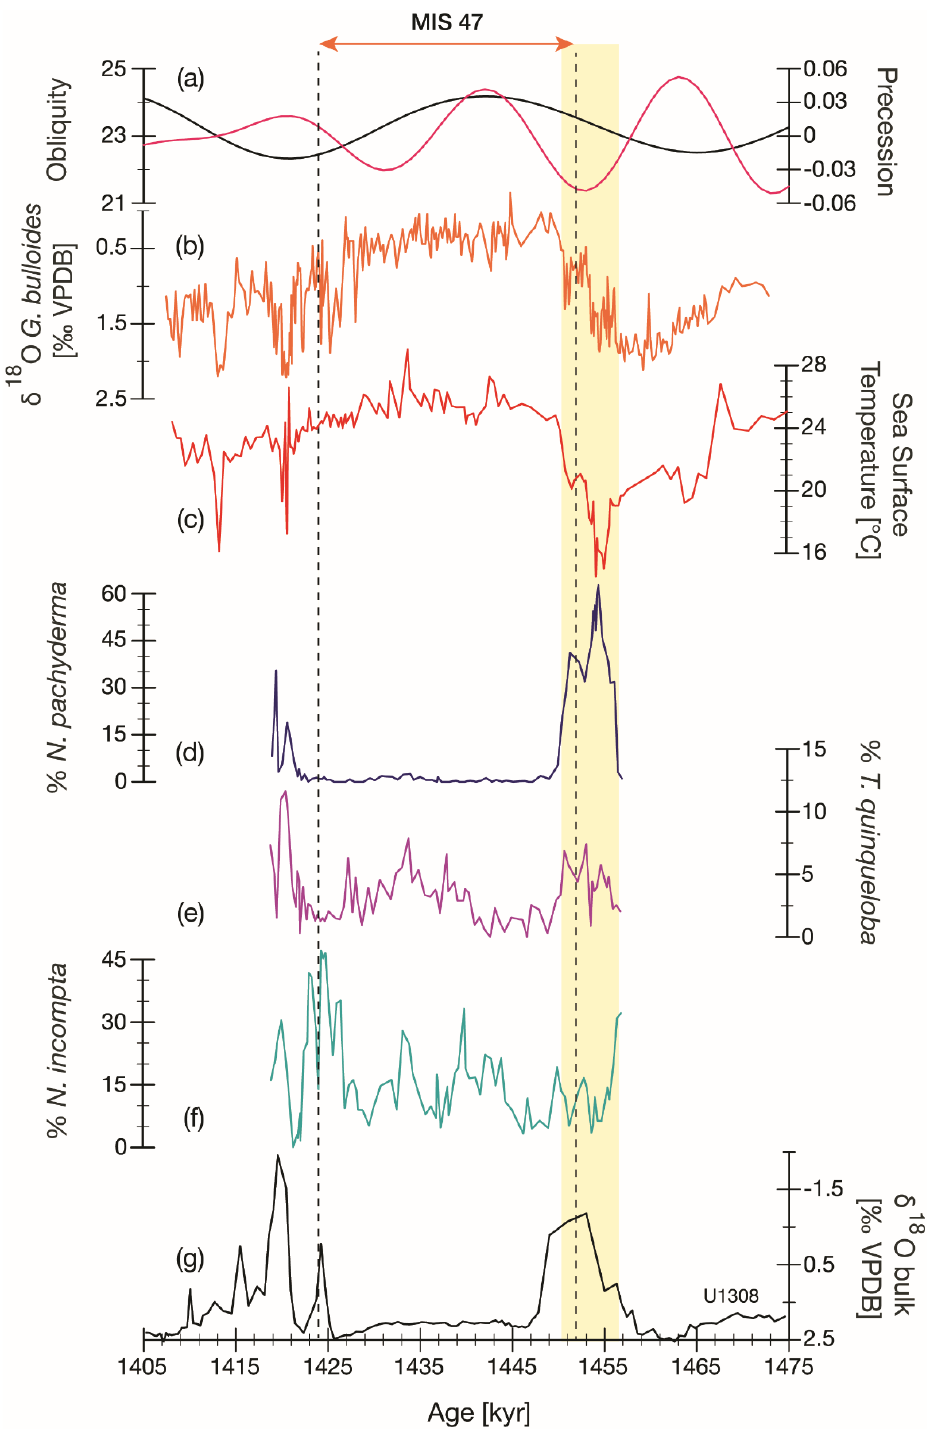
Figure 5. Terminal stadial event of MIS 48 (yellow bar) and millennial-scale variability in MIS 46 at IODP Site U1387: ( a ) Obliquity ( black ) and Precession (dark magenta) [63]; ( b ) G. bulloides δ 18 O record; ( c ) U k’ 37 sea surface temperatures; ( d ) percentage of polar species N. pachyderma in the planktonic foraminifera assemblage; ( e ) percentage of subpolar species T. quniqueloba ; ( f ) percentage of subpolar species N. incompta; ( g ) δ 18 O bulk carbonate record of IODP Site U1308 [10] with peaks of lower values indicating ice-rafting events in the eastern North Atlantic.